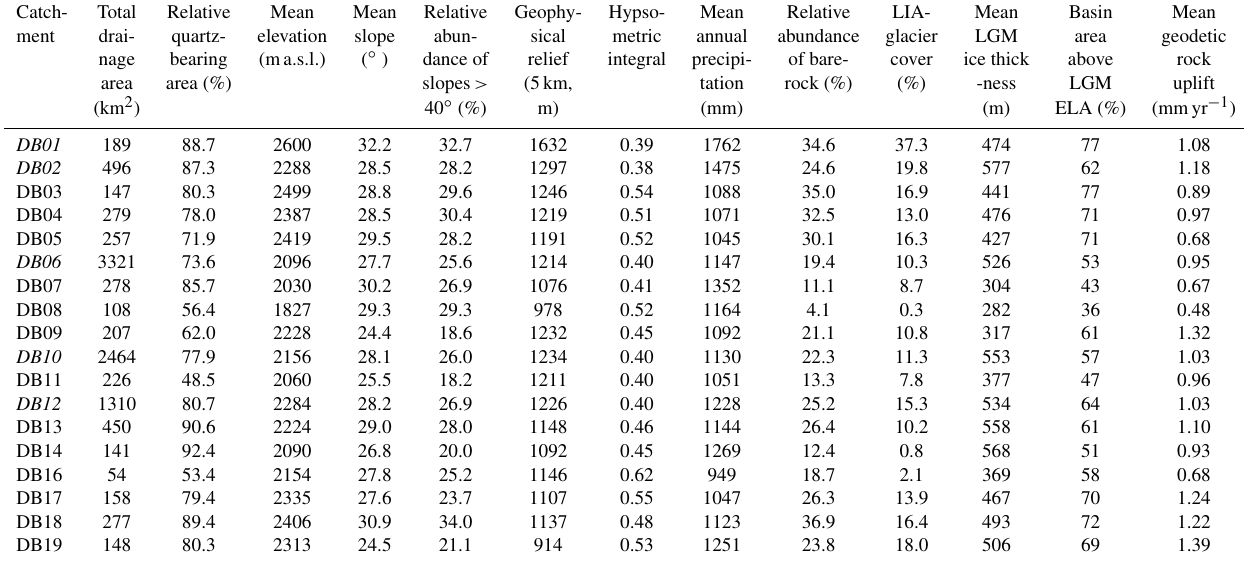
Table 2. Topographic, environmental and geological metrics extracted for the studied catchments (upstream of sampling river locations for 10 Be analysis). Names of sample collected along the main DB river are given in italics. With the exception of the total drainage area, all the metrics were calculated using the quartz-bearing area of each catchment. See text for